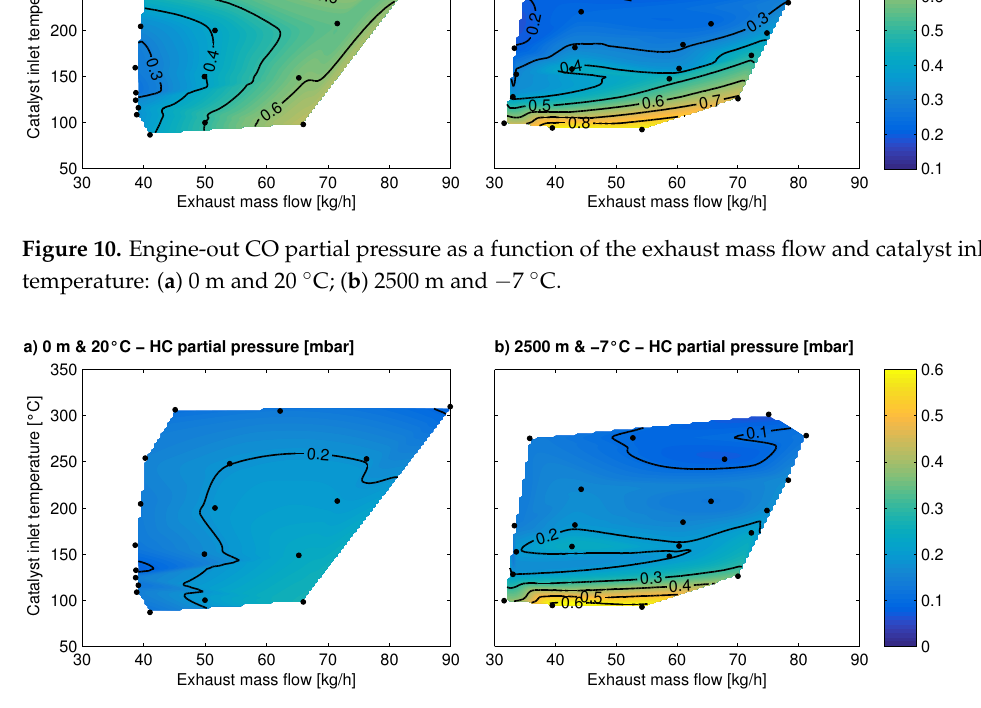
Figure 11. Engine-out HC partial pressure as a function of the exhaust mass flow and catalyst inlet temperature: ( a ) 0 m and 20 ◦ C; (b) 2500 m and − 7 ◦ C.